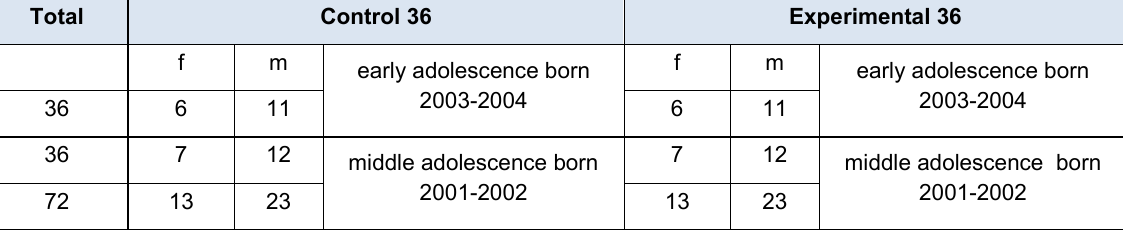
Table 1: Experimental and Control Group